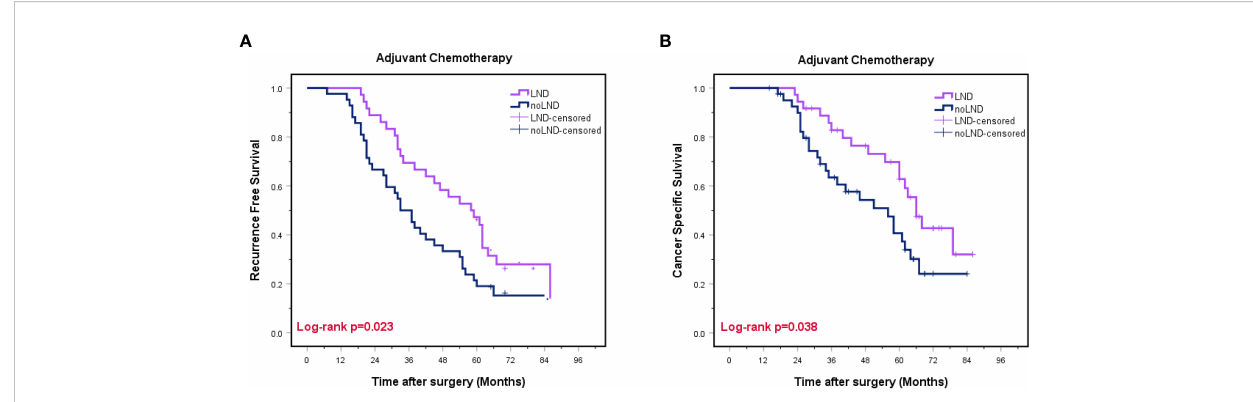
FIGURE 4 Kaplan-Meier curves for recurrence-free survival (A) and cancer-speci fi c survival (B) in subgroups strati fi ed by adjuvant chemotherapy. LND, lymph node dissection, Red font means P value <